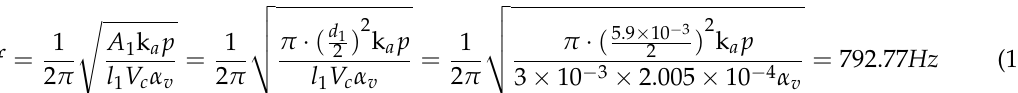
Figure 12. Instantaneous energy density of various pressure drops.